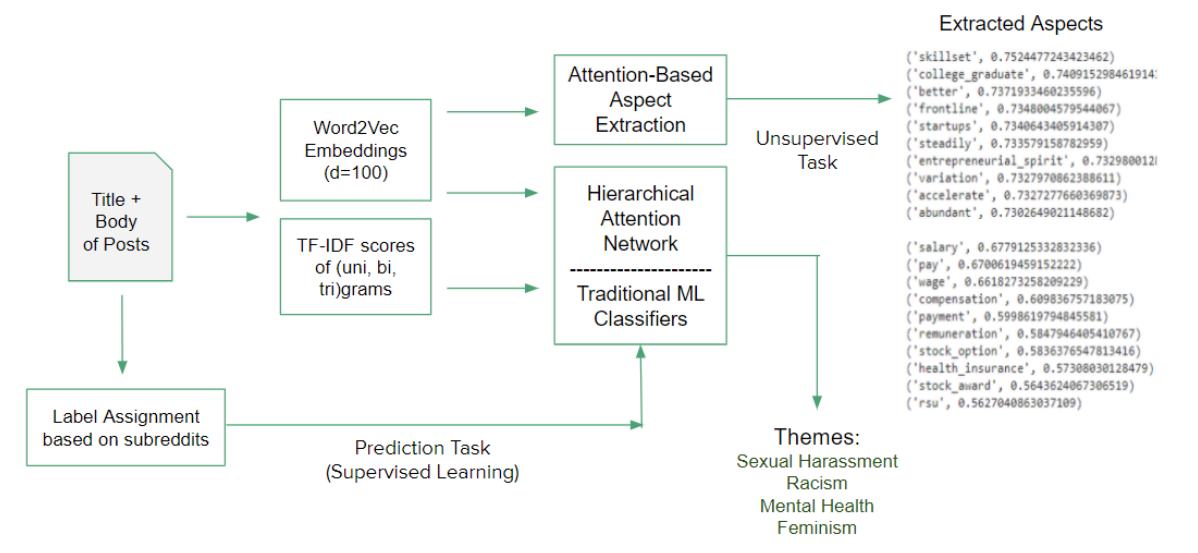
Figure 4 . Proposed